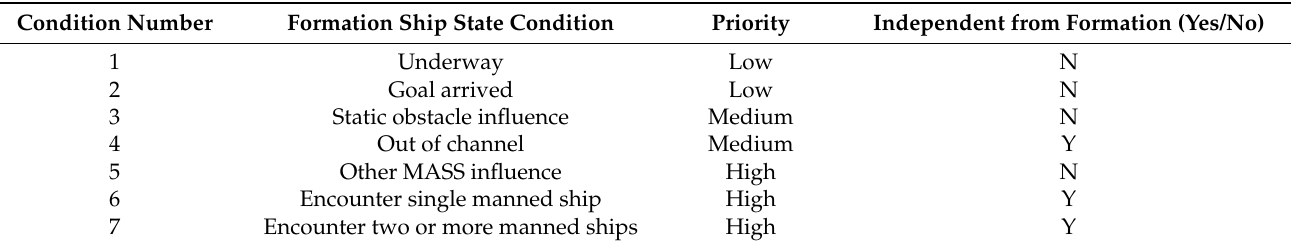
Table 2. MASS (unmanned ship) Formation Ship State